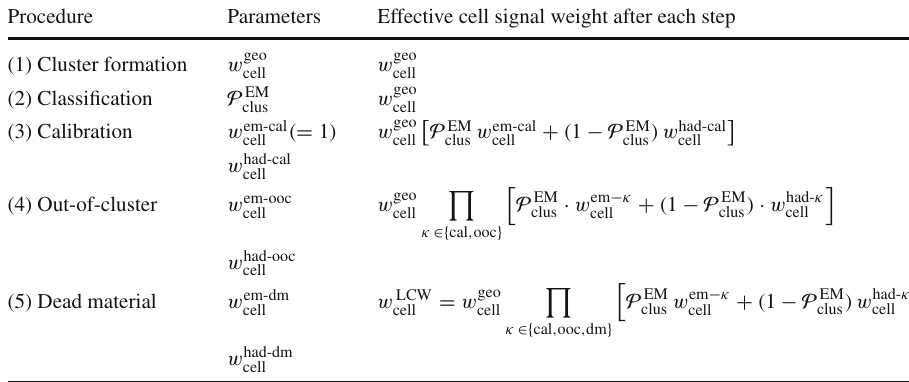
Table 3 Summary of the calibration and correction sequence applied to topo-clusters from the EM to the final LCW scale